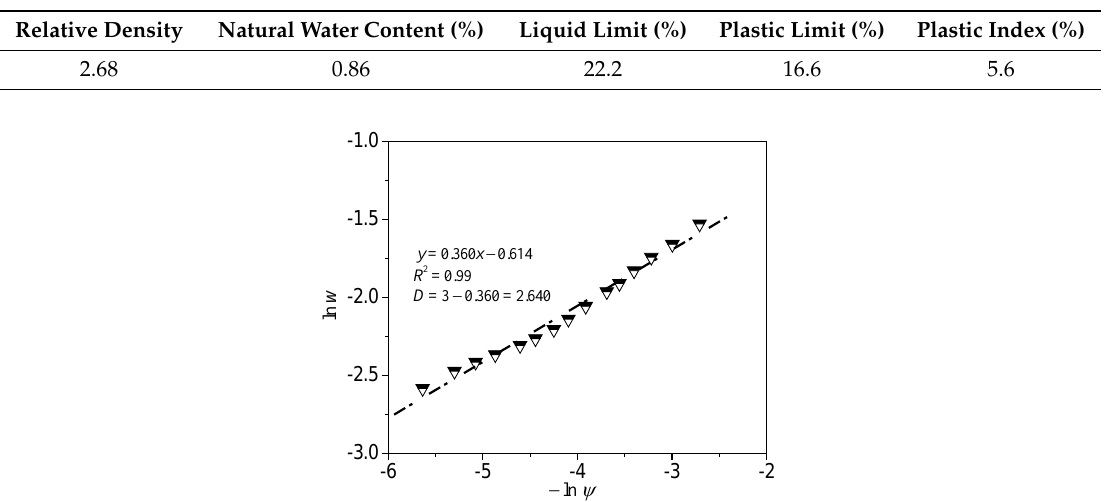
Table 5. Physical properties of Saskatchewan silt (data after Huang [43]).